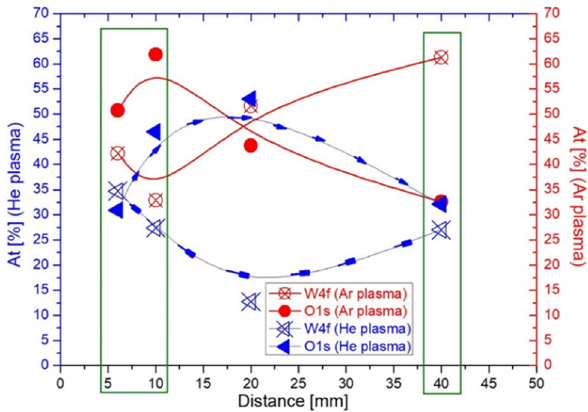
Figure 16. XPS analysis of the obtained particles in He-HC and Ar-HC discharges: The influence of distance upon W4f and O1s atomic concentrations.